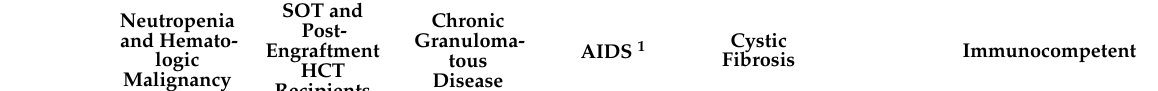
Table 1. Differential diagnosis of non- Aspergillus hyaline mold pathogens according to host factors and clinical